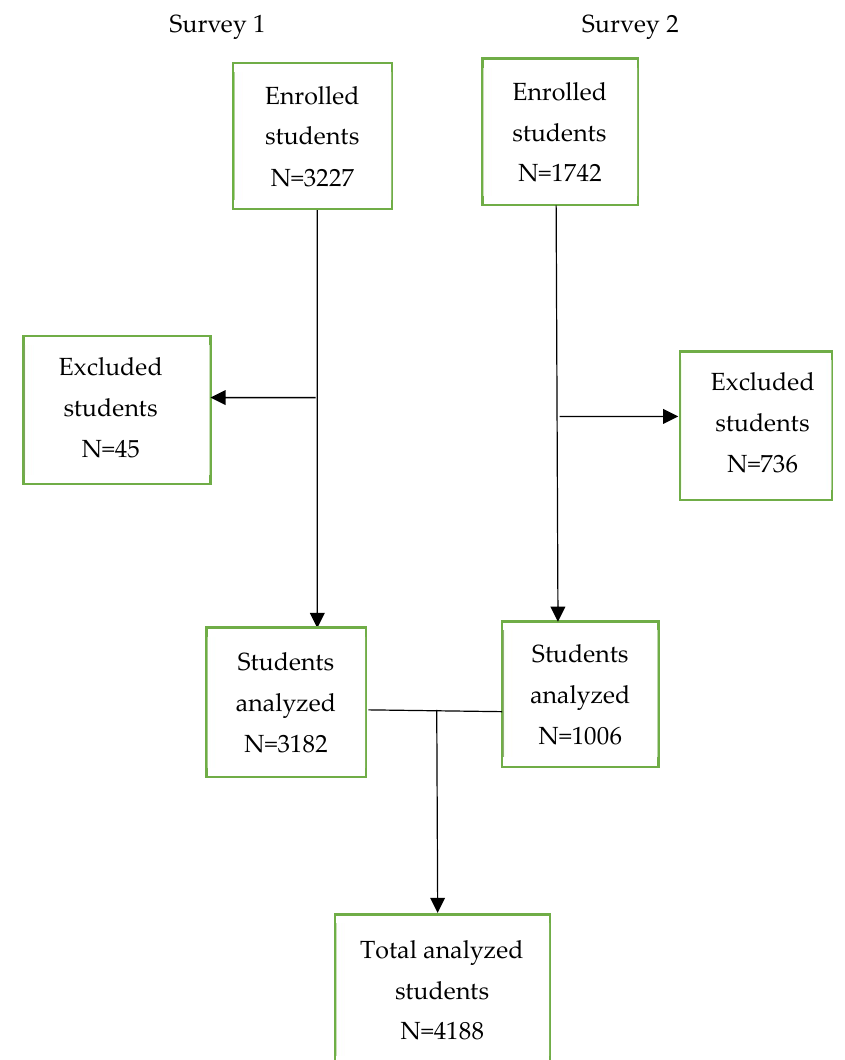
Figure 1. A flow diagram of enrolled and analyzed participants in the two surveys.